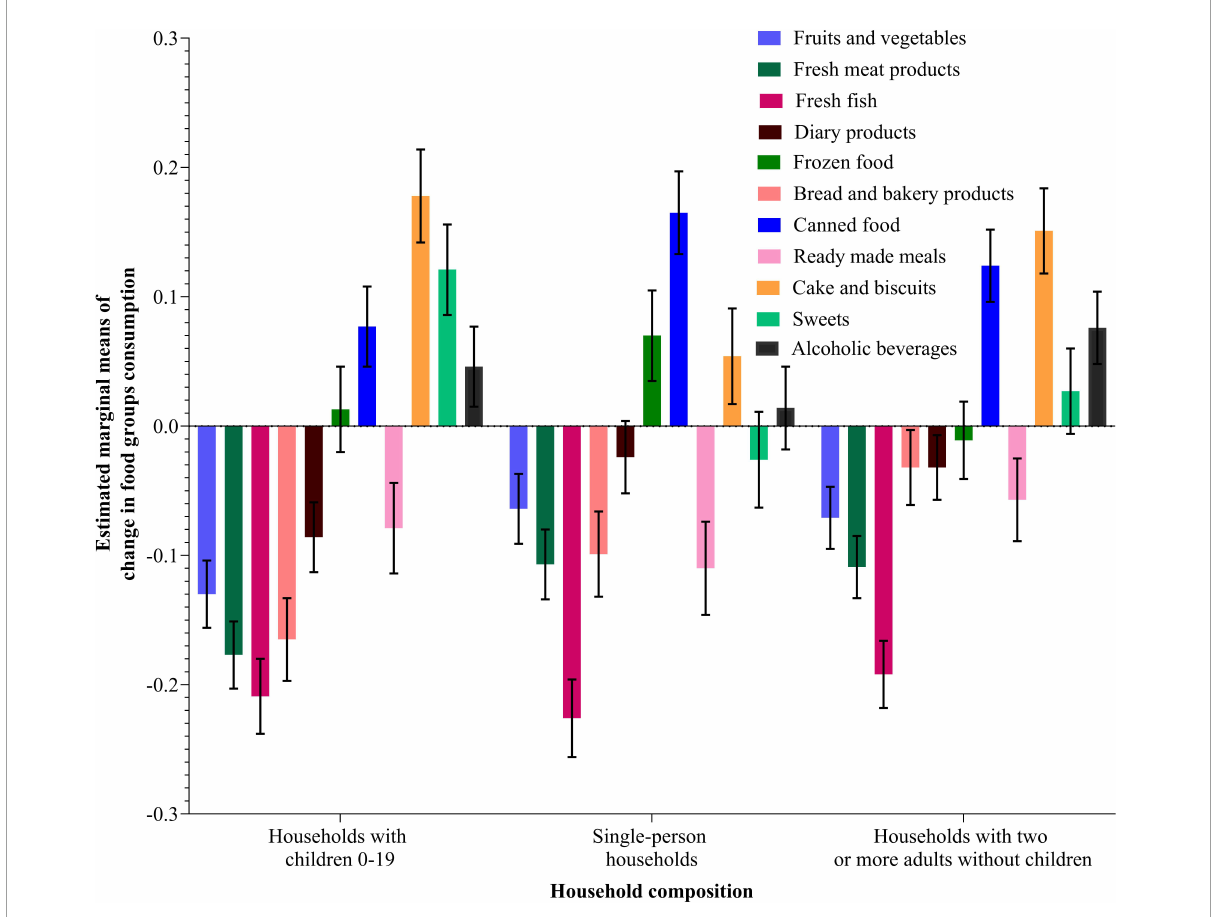
FIGURE3 Estimated marginal means using the MANOVA procedure for different food types consumption change (During—Before COVID-19) per household composition categories. Data weighted by countries (see also Supplementary Table 3